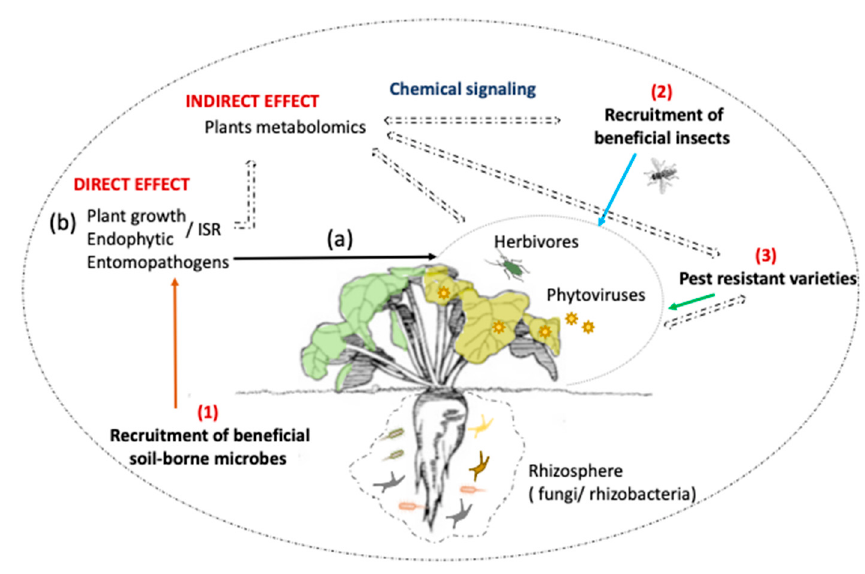
Figure 1. Biocontrol strategies team up with sugar beet in a multitrophic interaction context to control aphids and associated plant viruses. Depending on the control strategy, direct and indirect impacts have been highlighted. Direct effect (solid arrows) is assessed on both aphids and plants. ( a ) aphids: entomopathogenic effect (black arrow) and trophic interaction (blue arrow) are caused by EPF and aphid predators’ (i.e., hoverfly larvae) recruitment, respectively. The selection of aphid–sugar beet resistance varieties also plays a role in the limitation of aphid infestation and therefore virus infection (green arrow). ( b ) host plant: increment of plant growth parameters and induced systemic resistance against aphids are the consequences of endophytic fungi and/or bacteria and rhizobacteria recruitment (orange arrow). Indirect effect (dash arrow) refers to a series of semiochemicals induced by different sources (microbial treatment and plants following infestation with herbivores) and their impact on higher tropic levels (beneficial insects).